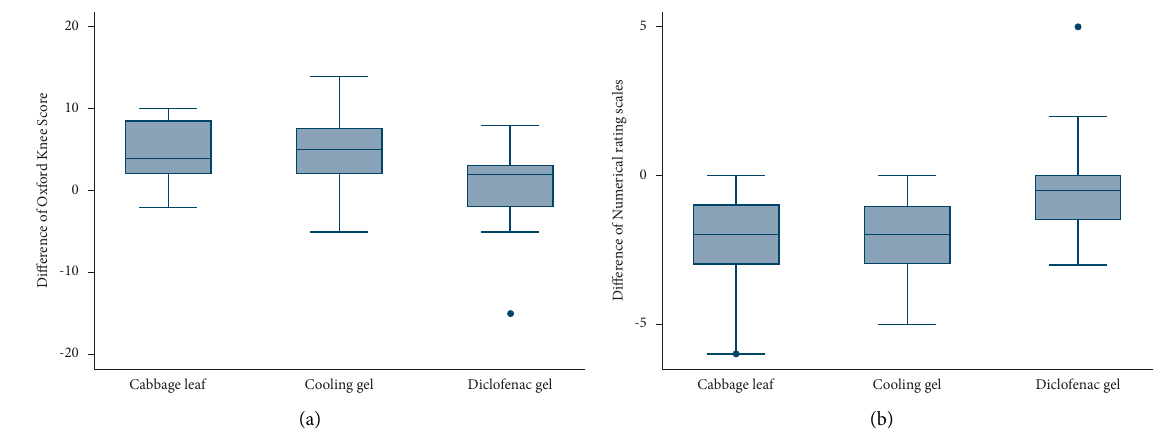
Figure 3: (a) Boxplots showing differences in Oxford knee score and (b) boxplots showing differences in NRS